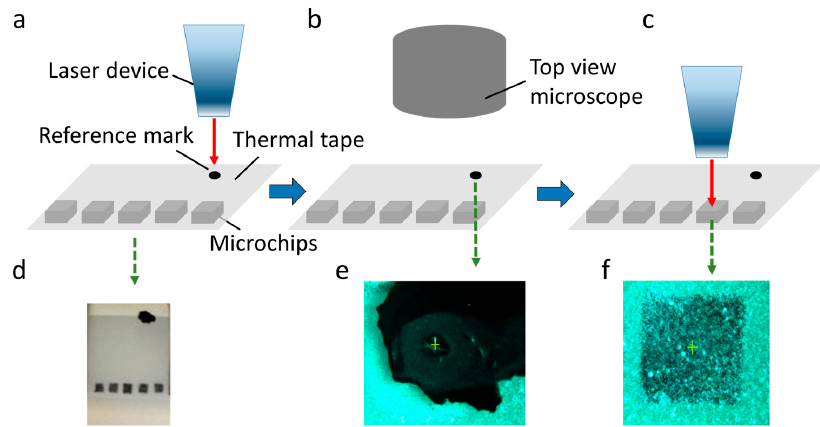
Figure 7. Laser die releasing procedure: ( a , d ) a reference mark was moved under the laser beam and the laser was fired at the mark to make a burn; ( b , e ) the reference burn mark was moved under a top view microscope and the center of the burn was stored and highlighted with a cross hair; ( c , f ) the laser beam focal point was aligned with the center of the chip and the laser was ready to fire to release the chip from the thermal release tape.